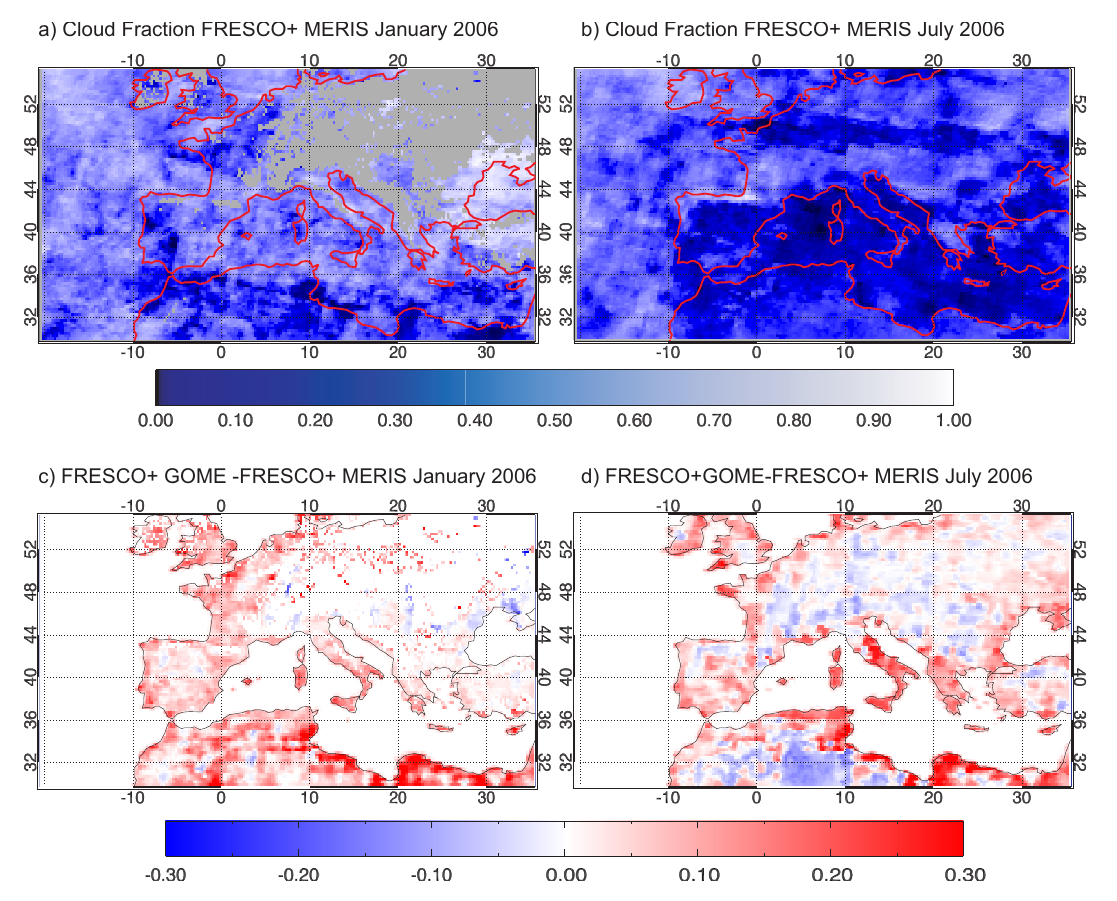
Fig. 6. Monthly mean FRESCO+MERIS effective cloud fraction (a–b) as well as the absolute differences (c–d) to FRESCO+GOME over Europe for January and July 2006. Note that ocean pixels are processed with the GOME LER data also in the MERIS retrieval so that no differences occur over water. Grid cells with no valid retrieval, e.g. due to permanent snow coverage are given in a grey